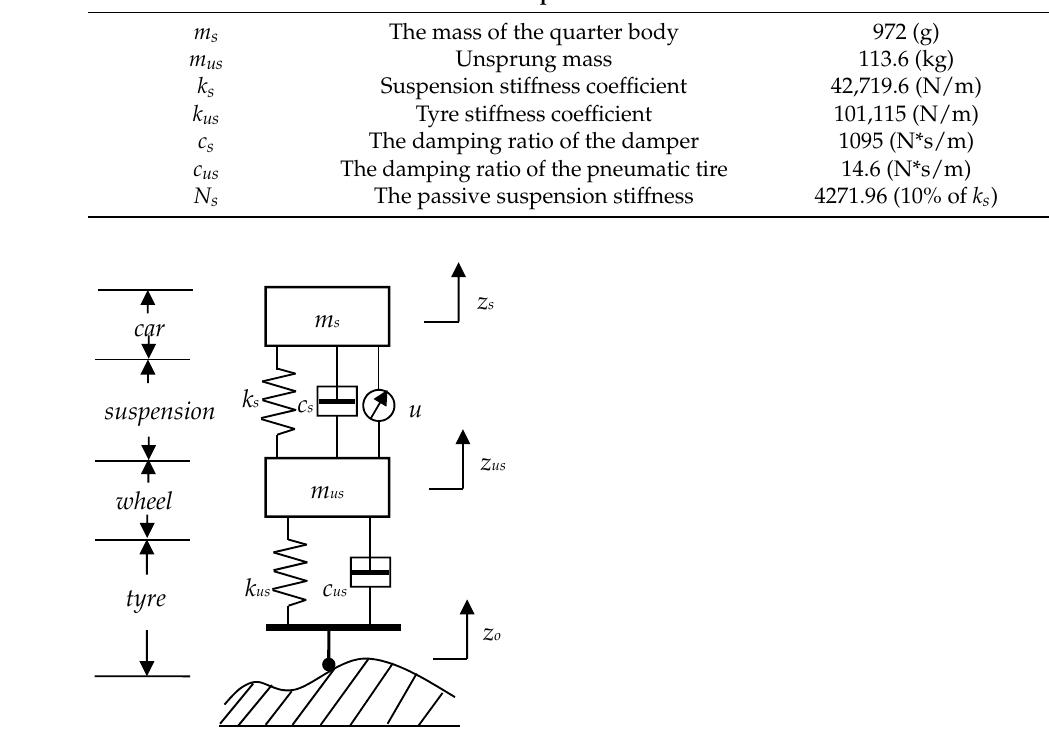
Figure 1. Nonlinear active quarter-car suspension model.